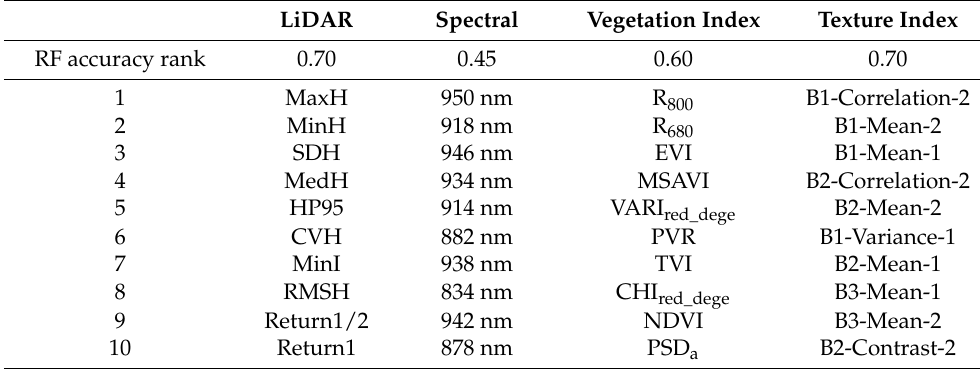
Table 5. Importance ranking of the feature factors.